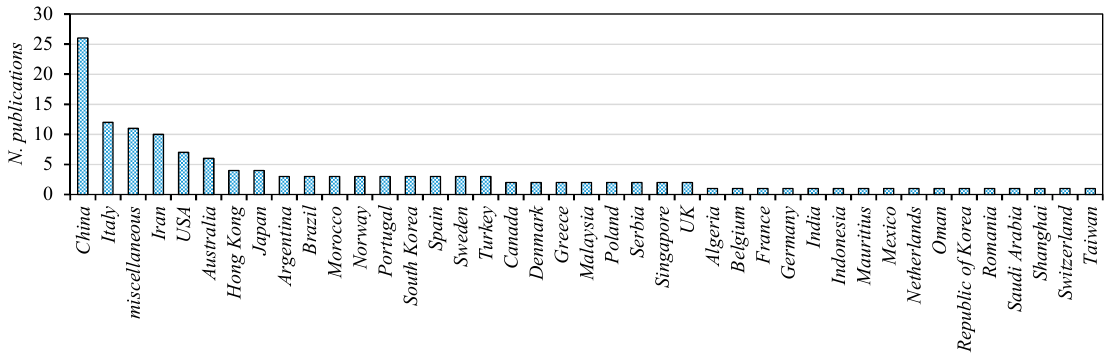
Figure 3. Spatial distribution of the case studies investigated in the reviewed journal articles. Studies applying the MOO workflow to various latitudes are clustered in the “miscellaneous” category.